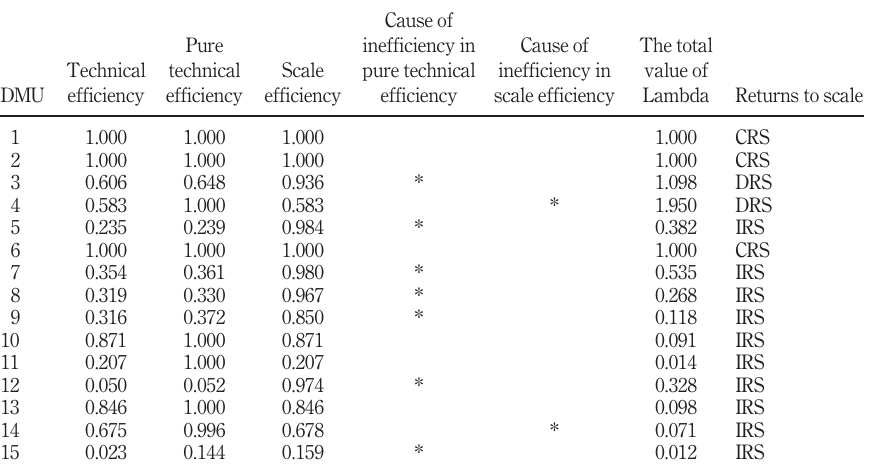
Table X. Cause of inef fi